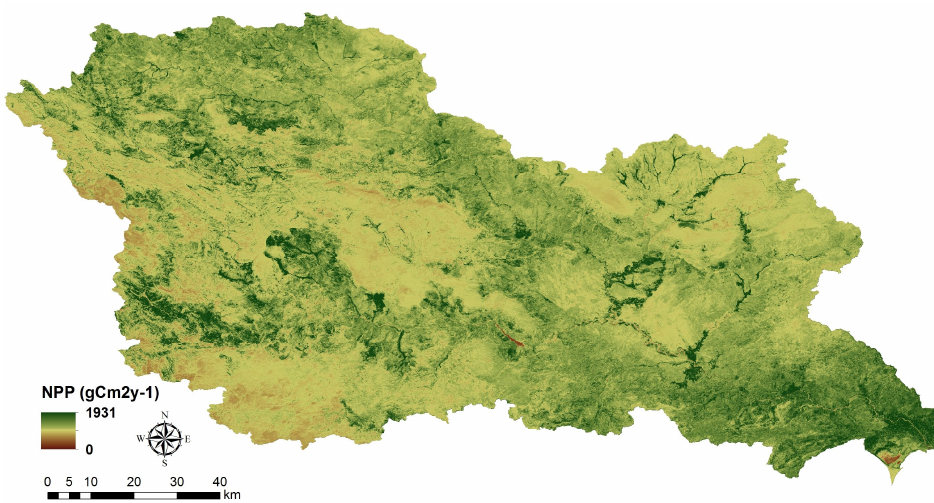
Figure 4. Total Annual NPP Map derived from the CASA-30 m.